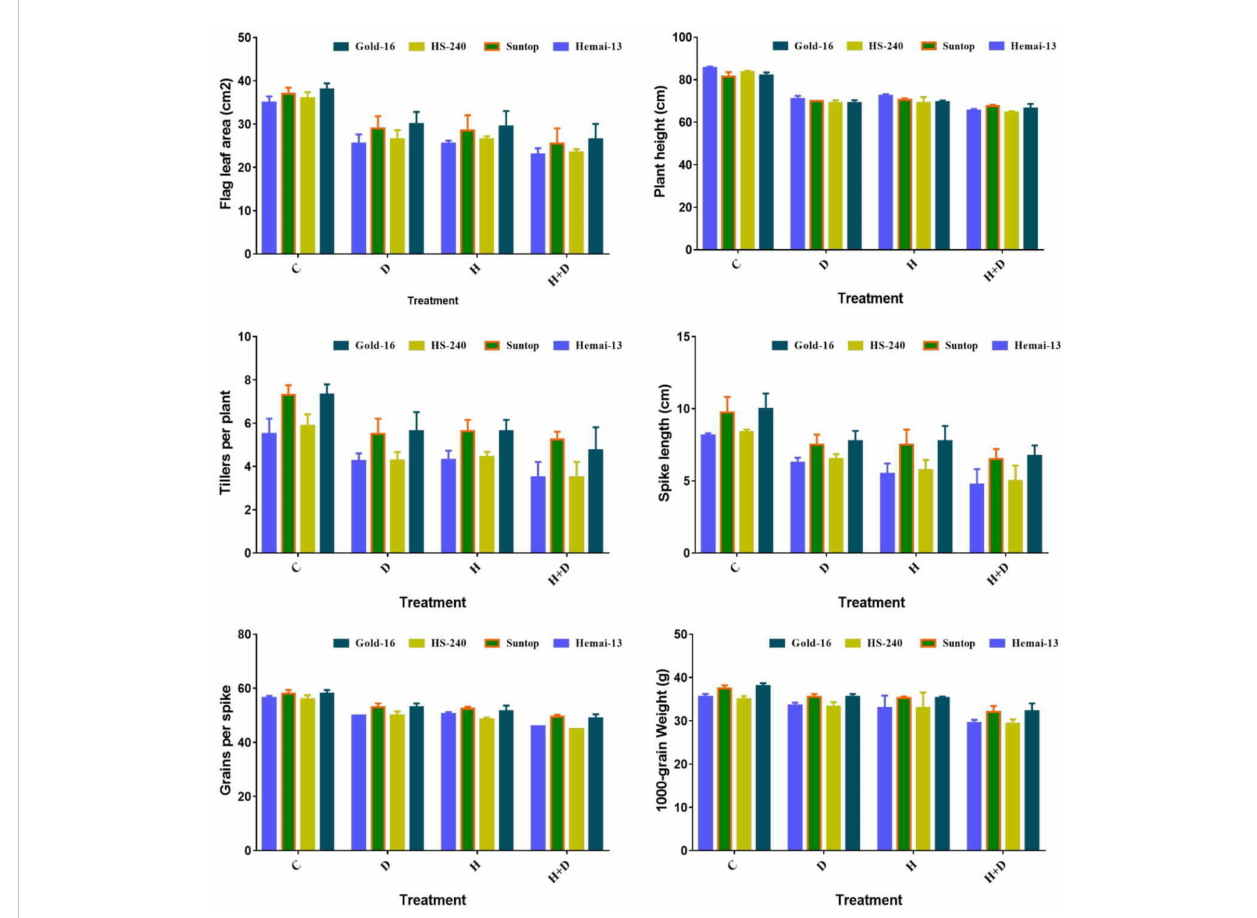
FIGURE 4 Variation in growth and yield traits of wheat cultivars due to individual and combined treatments of drought and heat stresses. Values in the graph are means averaged after harvesting during the two-factorial tri-replicate experiment at a p -value ≤